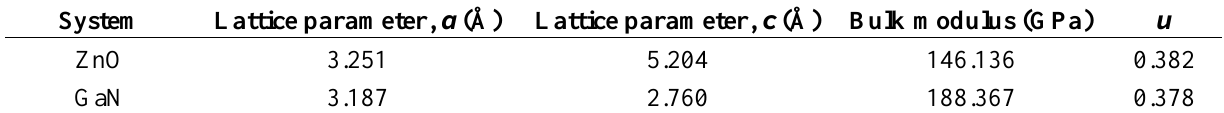
Table 5. Structural parameters of wurtzite